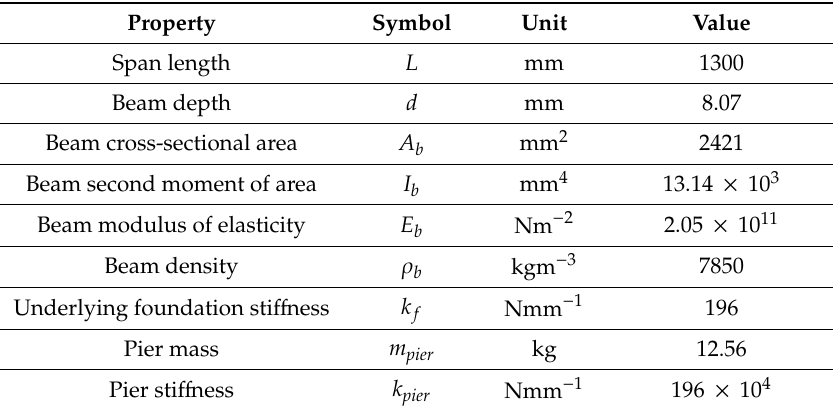
Table 2. Model properties.